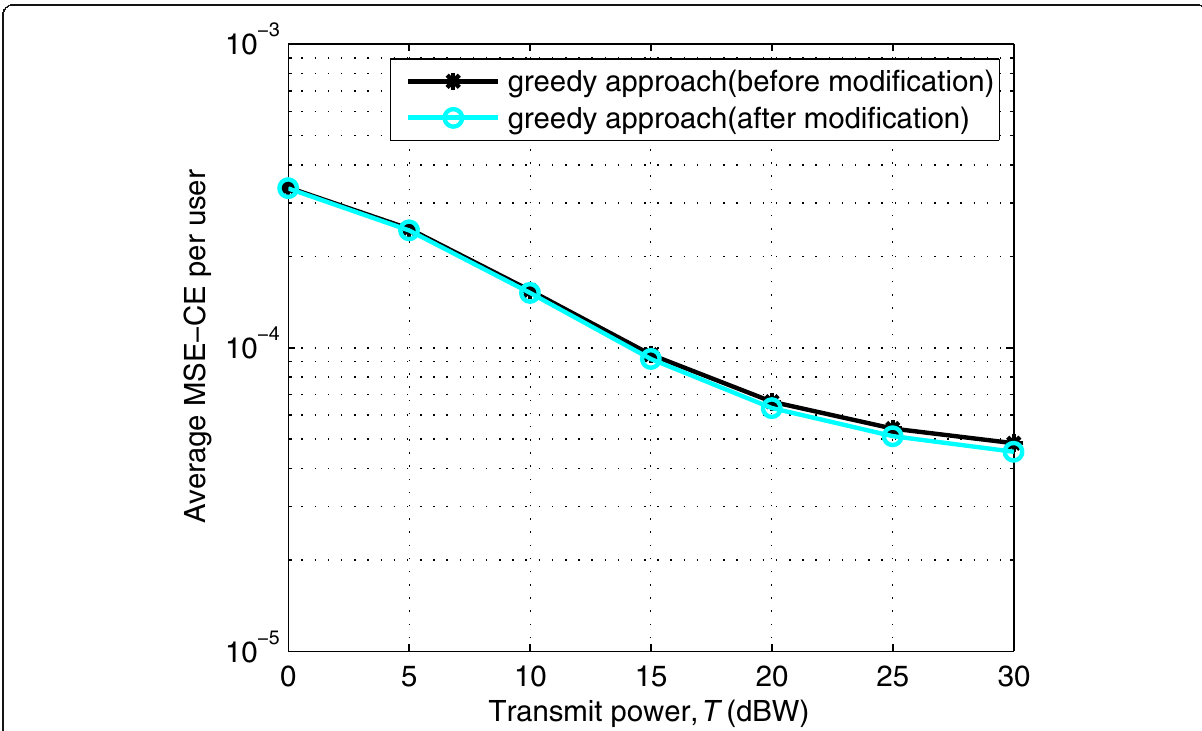
Fig. 3 Comparison of the greedy approach before and after the modification